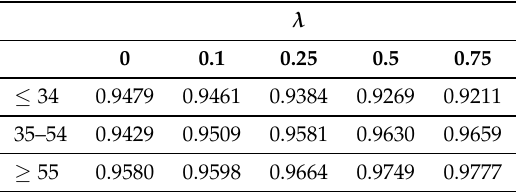
Figure A12. Graphic illustration of the global preferences stability measures from different values of λ and different age ranges for Question 2. Table A9. Global stability measures for Spaniards’ preferences attending to different age ranges and several values of λ for Question